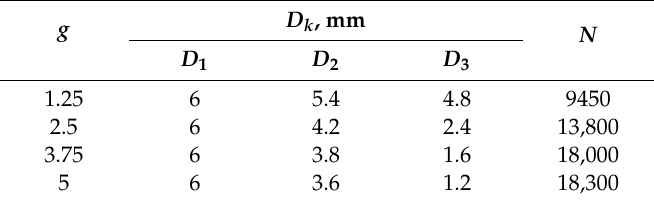
Table 2. Values of D k along with N for a given value of g in mixtures with particle size distribution (PSD) uniform by number of spheres.